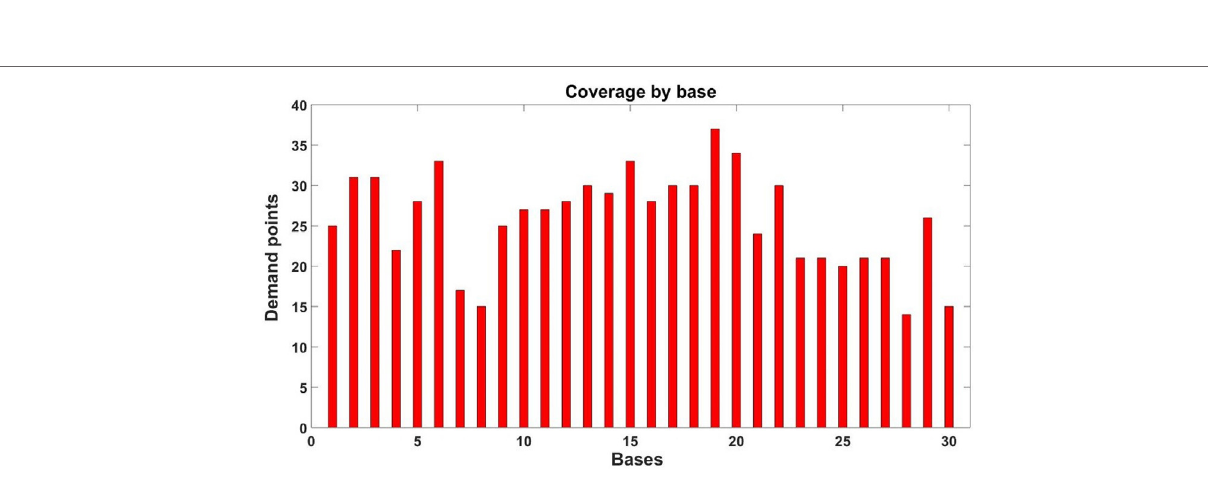
FigUre 14 | Demand points that cover each base.